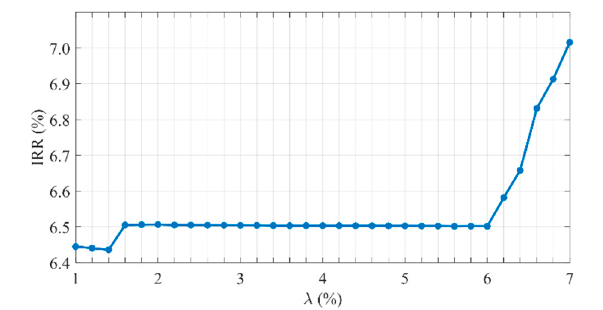
Figure 8. IRR of the solutions within the optimization search guided by the IRR.